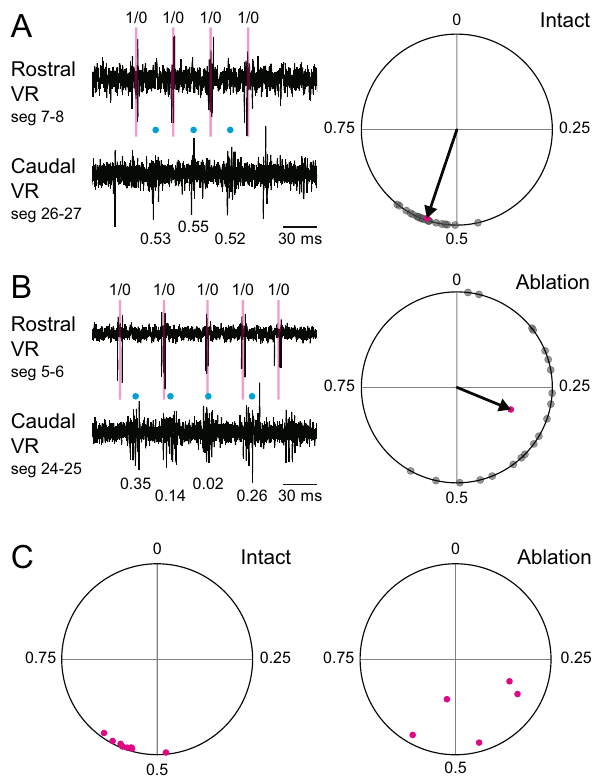
Figure 6. Anti-phasic relationship of the rostral and caudal motor activities is impaired in MCoD-ablated fish. ( A ) Left panel, An example of the dual (rostral and caudal) VR recordings. For the phase analysis, the middle time point of a rostral VR activity was assigned a phase value of 0, and that of the next VR activity was assigned a phase value of 1. Right panel, Circular plot of 20 randomly selected caudal VR activities with respect to rostral VR activity during fictive swimming. ( B ) Same as (A) but for MCoD-ablated fish. ( C ) Left panel, Circular plot for the recordings from intact fish (n = 8). Right panel, Circular plot for the recordings from MCoD-ablated fish (n =